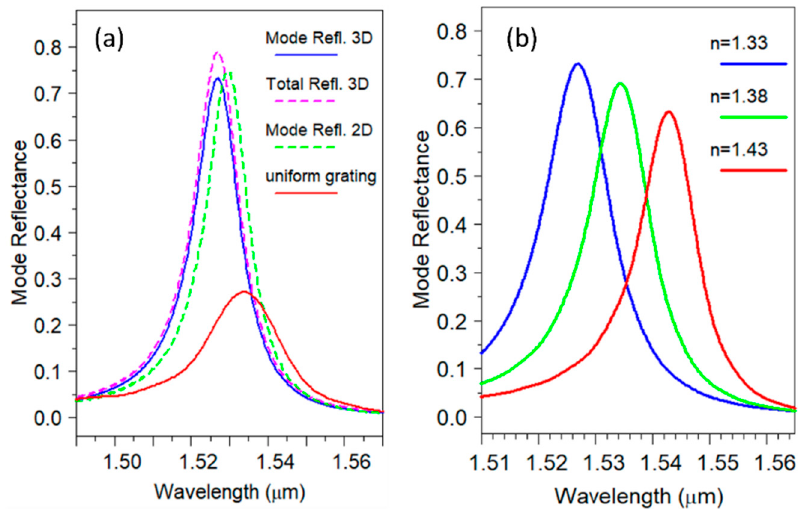
Figure 6. ( a ) Mode reflectance (blue), total reflectance (magenta) for a 3D fiber RWG, mode reflectance for a 2D model (green) and mode reflectance of uniform grating (red); ( b ) Spectral response for different ambient refractive indices.